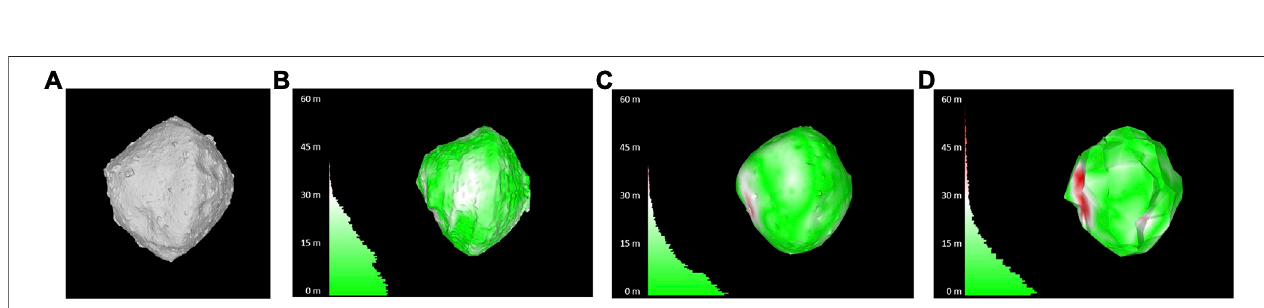
FIGURE 14 | Example coarse mapping results from the experiment, using 300 features. (A) Ground truth, (B) shape-from-silhouette model, (C) Poisson surface reconstruction model, and (D) Powercrust model.